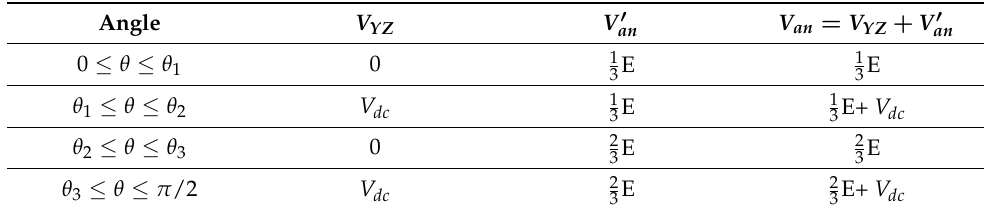
Figure 6. Phase-output voltage of the AHMMC operating at a different angle. Table 2. AHMMC output phase voltage ( V an )